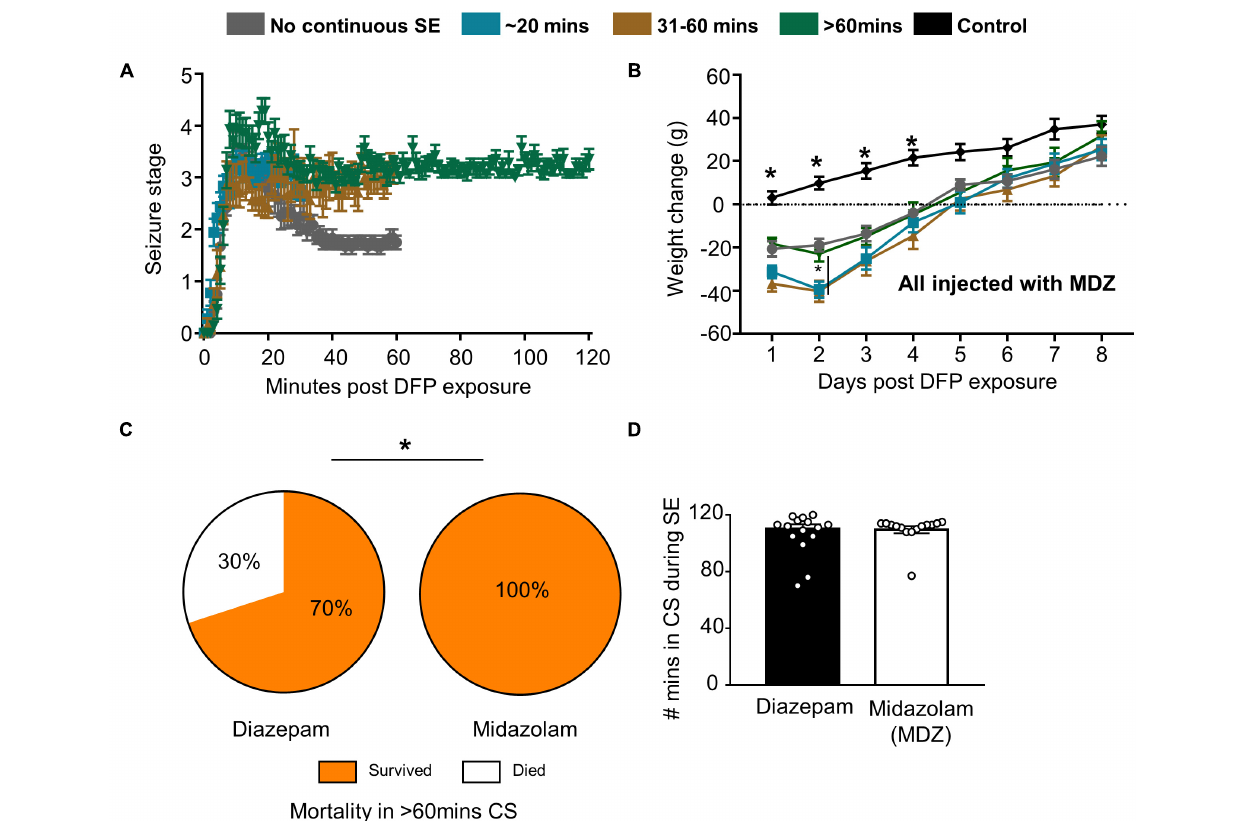
FIGURE 3 | Impact of SE duration and severity on bodyweight and mortality. (A) Following DFP, animals were monitored for seizure severity using a modified Racine scale (1-5) on each minute. Average seizure stage at each minute is depicted. (B) Weight change over time for each group of animals (mixed measures ANOVA, n = 7-15). (C) When midazolam was given 2 h following DFP, surprisingly no mortality was observed (in the first 24 h compared to animals treated with diazepam from a previous study (Chi-square, n = 15-20). (D) There was no significant difference in seizure severity (number of minutes of convulsive seizures) between the animals given midazolam and diazepam ( t -test, n = 15-20). Error bar indicates standard error of the mean. * p < 0.05 compared to DFP groups or as indicated by the vertical